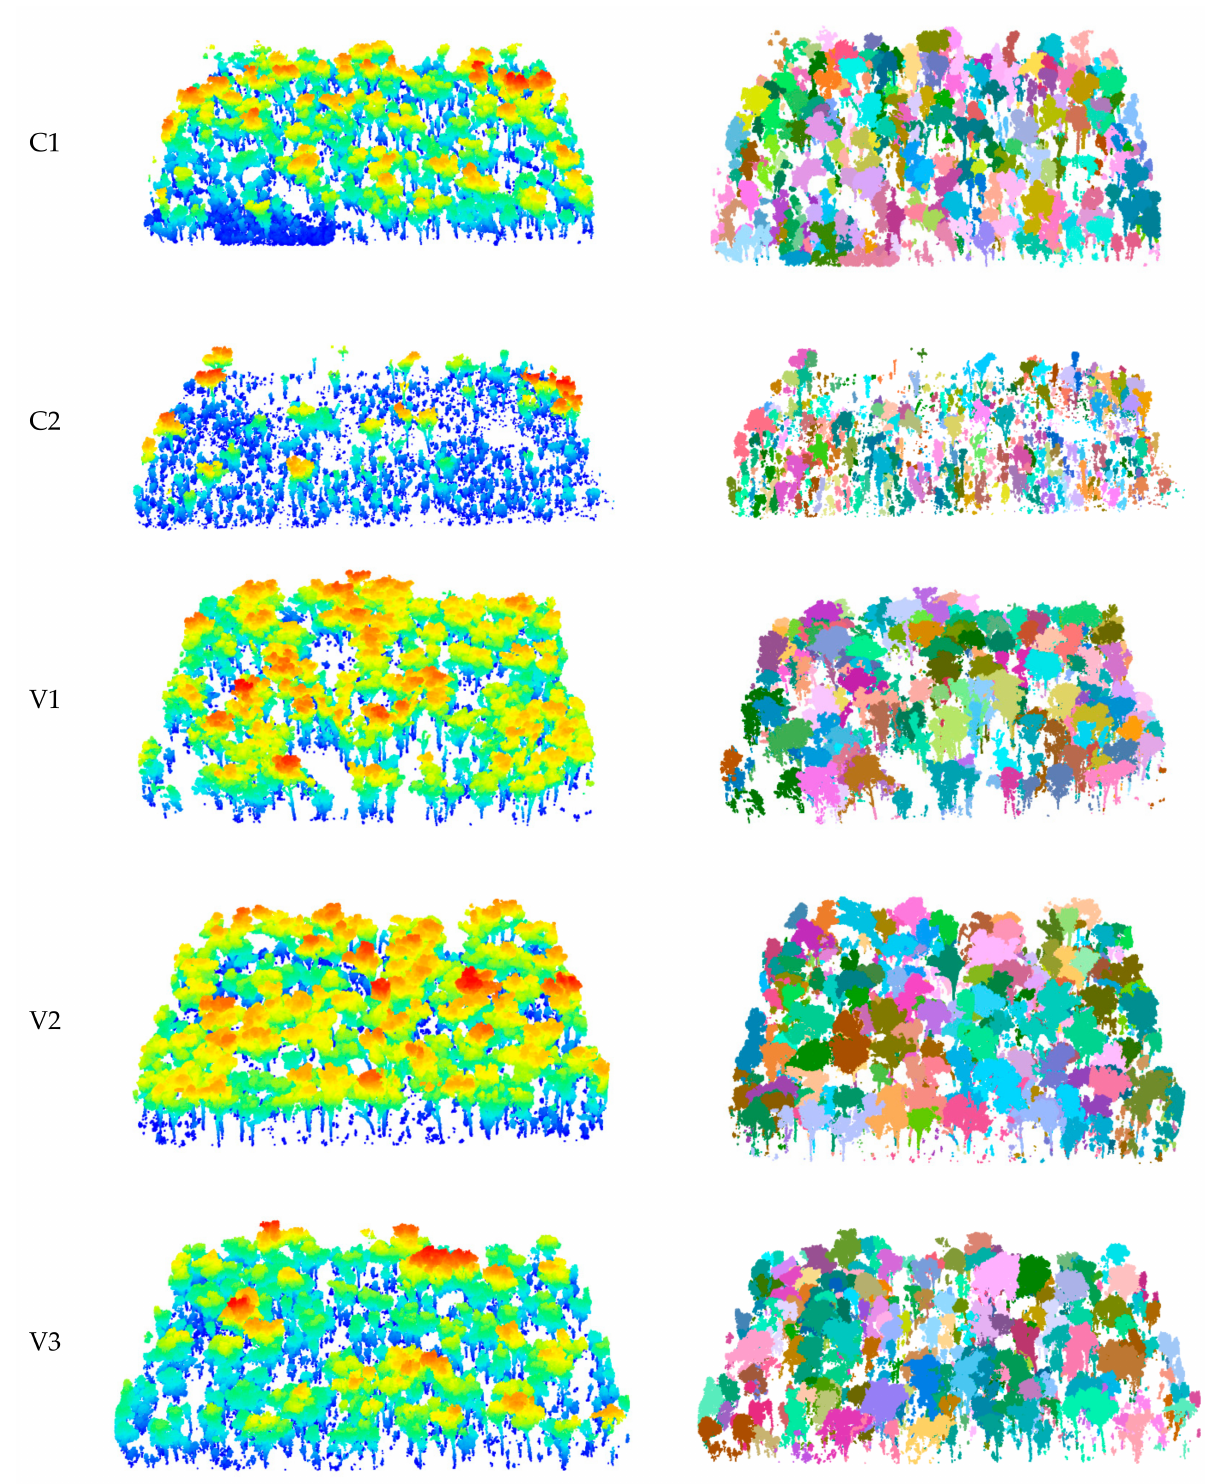
Figure A2. LiDAR point clouds of all five plots prior to segmentation ( left ) and after segmentation ( right ). In the left column, color represents height above ground level, and on the right column, colors represent individual